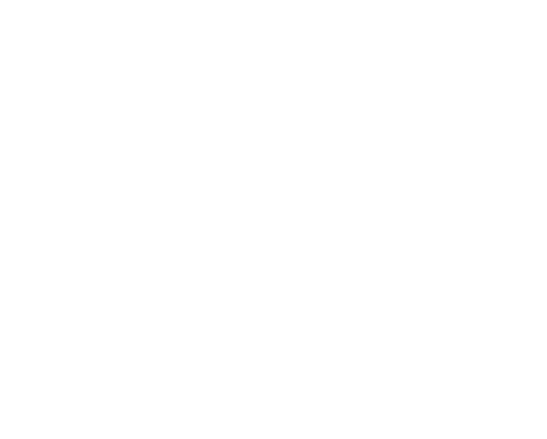
Figure 3. The network contact graph Gi of node